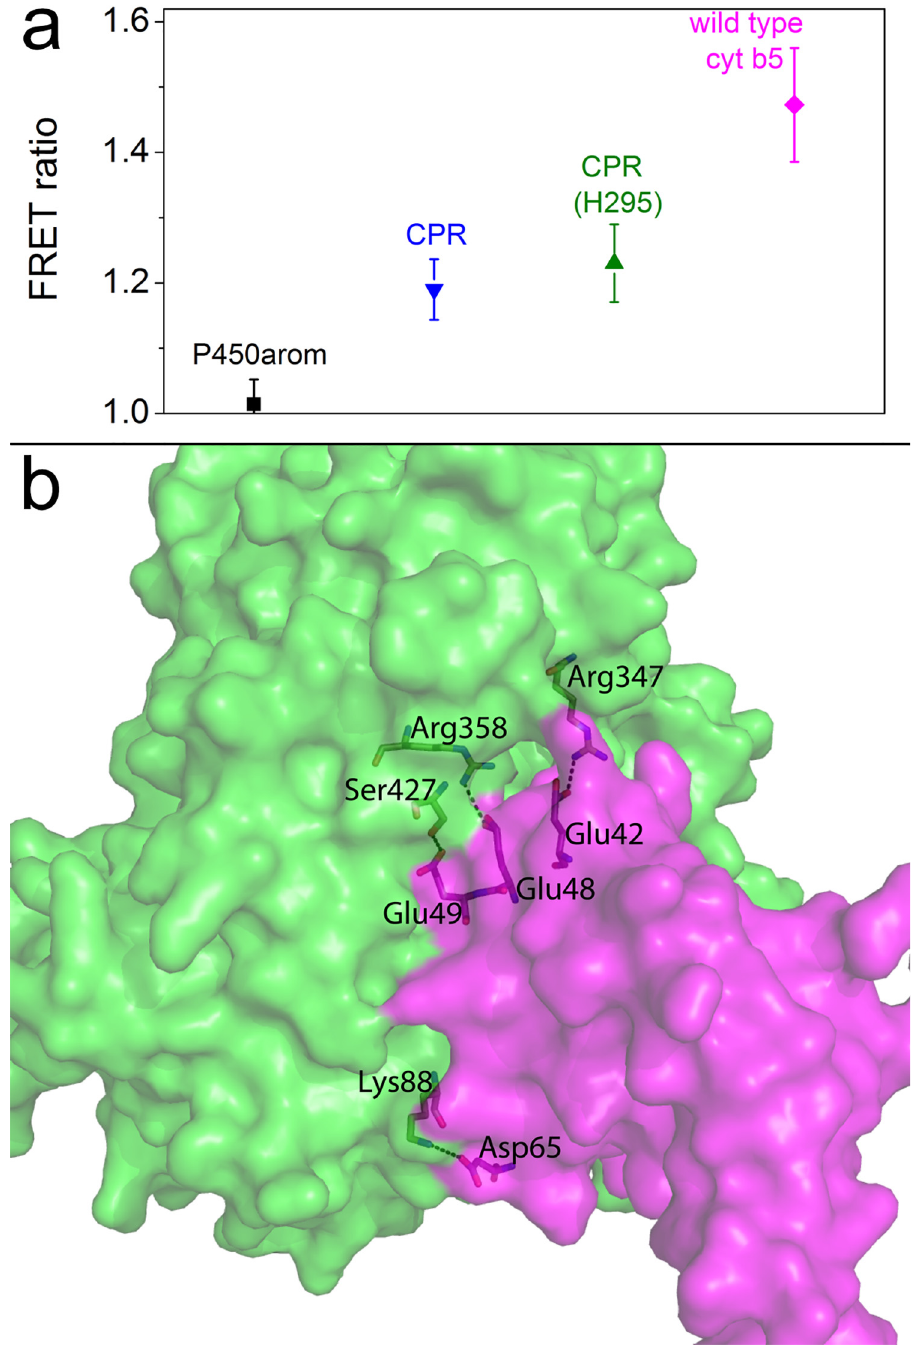
Fig 1. FRET ratio data for P450c17 and cyt b5 or CPR. a, The results of FRET pairs expressed in HEK293 or H295 (CPR, H295) cells. Fusion constructs P450c17-eYFP+CPR-eCFP ( ▲ and ▼ ; positive controls) and P450c17-eYFP+P450arom-eCFP ( & ), where P450arom is a negative control. 17 Importantly, the P450c17-eYFP+cytb5-eCFP ( ♦ ) have the highest FRET ratio. b, Model of the complex between P450c17 (green) and cyt b5 (magenta) shown in rendered style. Polar interactions are shown as black dashed lines. Those residues involved in polar interactions are highlighted and labeled individually.